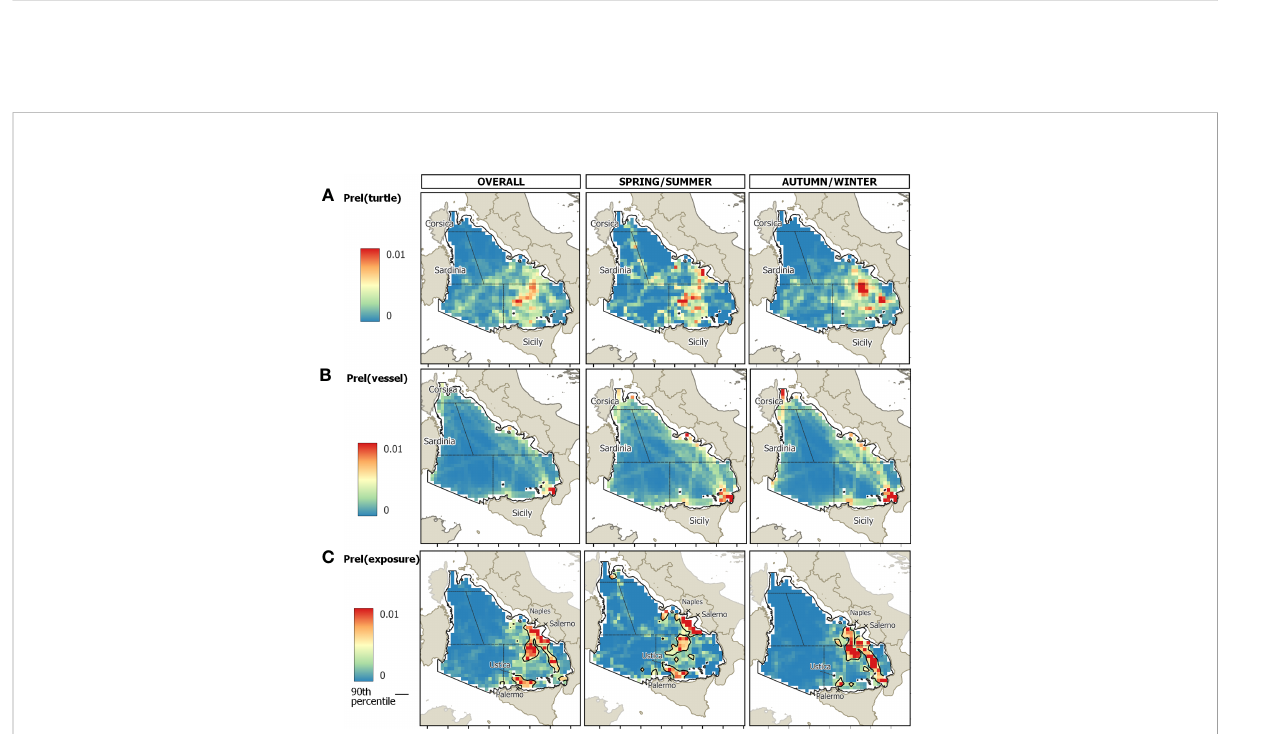
FIGURE 5 The oceanic TYS study area divided into cells of 15 km 2 (688 cells); colors indicate the relative probability of (A) loggerhead turtle occurrence (obtained through the application of the Brownian bridge kernel method to satellite data, see methods for details), (B) vessel occurrence, (C) and total vessel and turtle co-occurrence (exposure), calculated over the yearly average (1) or according to spring/summer (2) or autumn/ winter (3) averages.